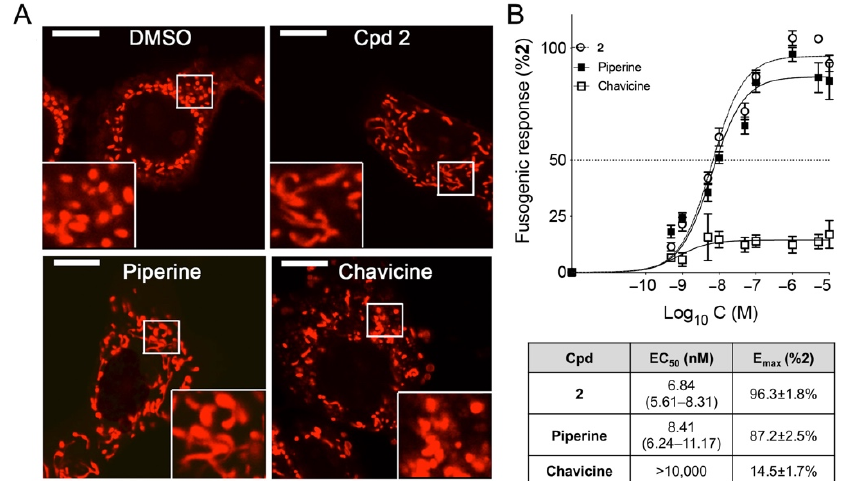
Figure 2. Dose-dependent stimulatory effects of piperine on mitochondrial fusion in Mfn2-null MEFs. ( A ) Representative confocal images of MitoTracker orange-stained Mfn2-null MEFs after overnight treatment with DMSO vehicle (1:1000, left) or 1 μ M Cpd 2 , piperine or chavicine. Insets are enlarged areas showing detailed mitochondrial morphology. Scale bars are 10 microns. ( B ) Concentration-response data for Cpd 2 ( n = 8; open circles), piperine ( n = 8; closed squares), and chavicine ( n = 3; open squares) to increase mitochondrial length/width (aspect ratio) in Mfn2-null MEFs. Data